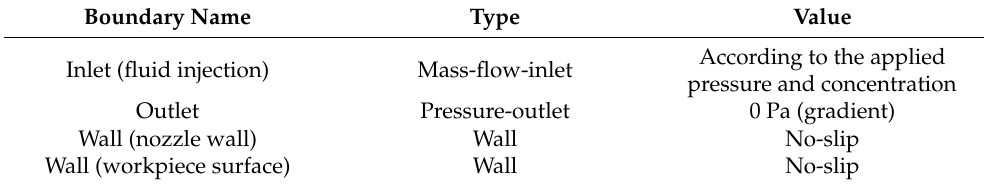
Table 3. Boundary conditions adopted in the numerical simulations. The mass flow rate of the liquid suspension injected at the boundary “Inlet” depends on the inlet pressure and particle concentration (See Figure